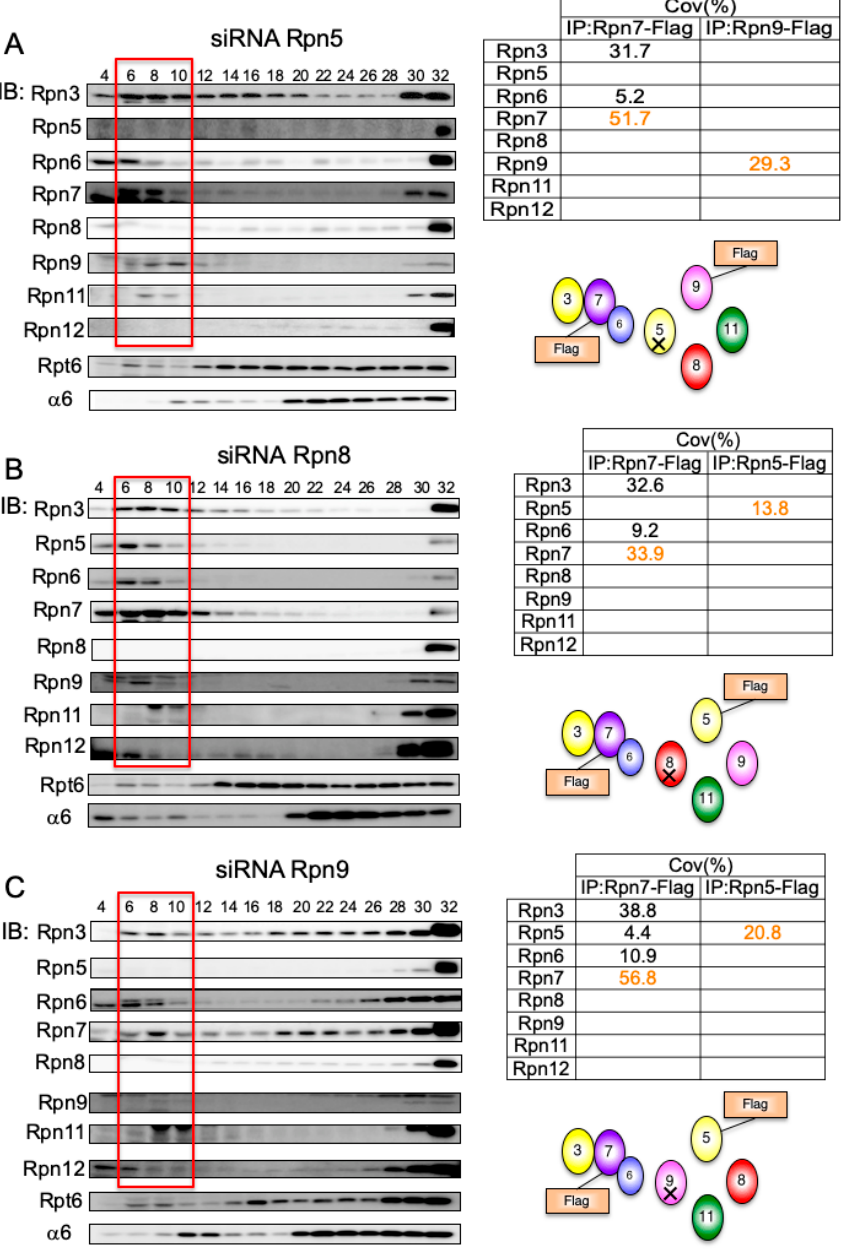
Figure 5. Interdependent assembly of the Rpn5-8-9 complex. HEK293T cells stably expressing Rpn7-Flag and Rpn9-Flag treated with siRNA targeting Rpn5 ( A ), cells stably expressing Rpn5-Flag and Rpn7-Flag treated with siRNA targeting Rpn8 ( B ), and cells stably expressing Rpn5-Flag and Rpn7-Flag treated with siRNA targeting Rpn9 ( C ) were analyzed in the same way as described in Figure 2. The tables show the sequence coverage of the identified subunits.